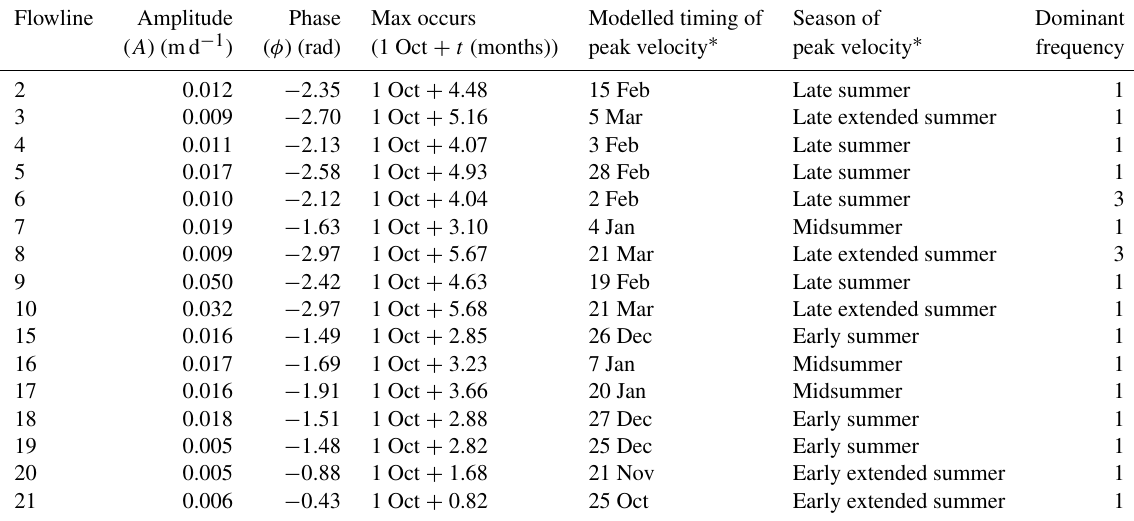
Table D1. Phase and amplitude characteristics of the fitted cosine function optimised to the dominant frequency determined by discrete Fourier transform analysis (Fig. D1, orange). Flowlines 2–10 drain Palmer Land, while flowlines 15–21 drain Alexander